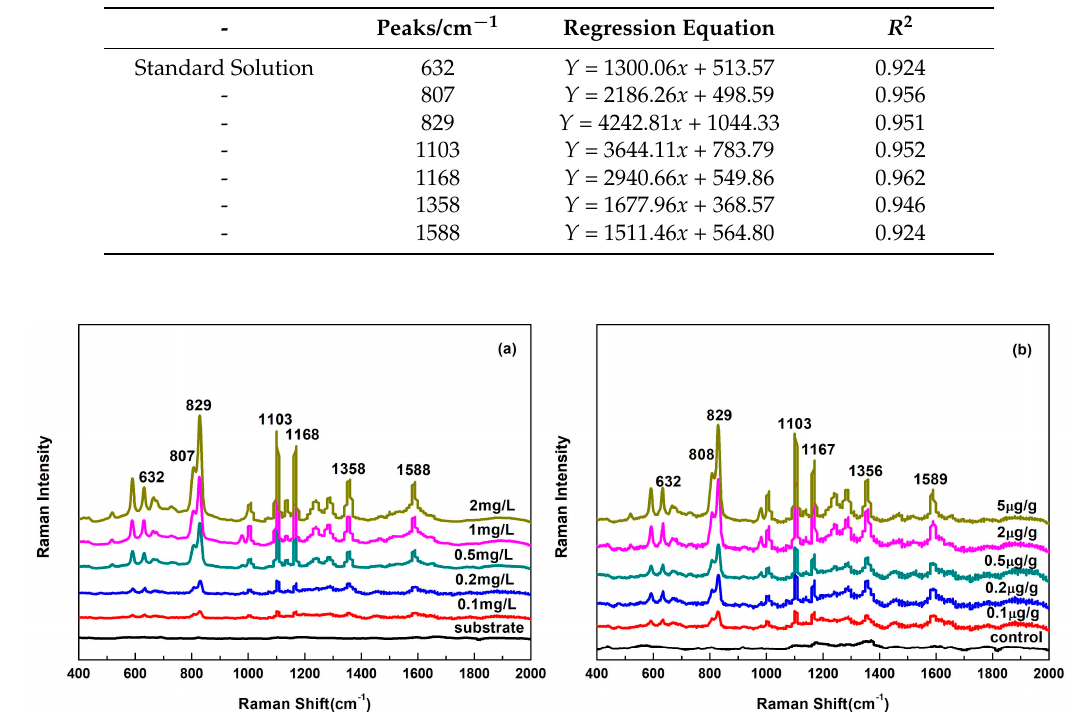
Table 1. Linear relationship between the different concentrations of flusilazole standard solution (0.1–2 mg/L) and the intensities of prominent characteristic peaks in the surface-enhanced Raman scattering spectra.